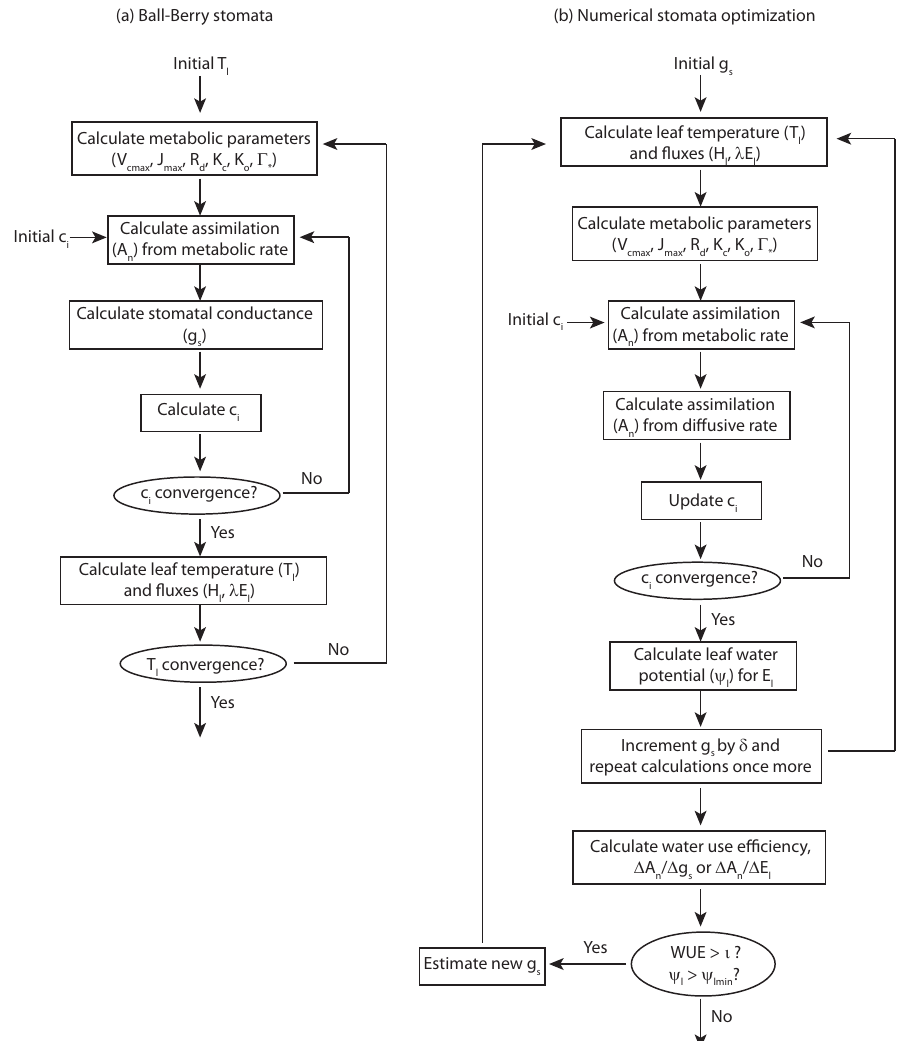
Figure 2 Figure 2. Flow diagram of leaf flux calculations using (a) the Ball–Berry model and (b) the SPA stomatal optimization. In both approaches, numerical methods are used to efficiently solve for g s . The SPA optimization is shown for water-use efficiency ( 1A n /1E l ) . The same approach is used for intrinsic water-use efficiency ( 1A n /1g s )